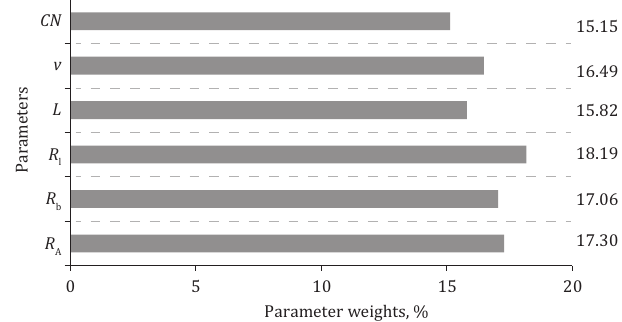
Figure 3. Factor analysis results indicating the weights of parameters obtained from cross-correlation